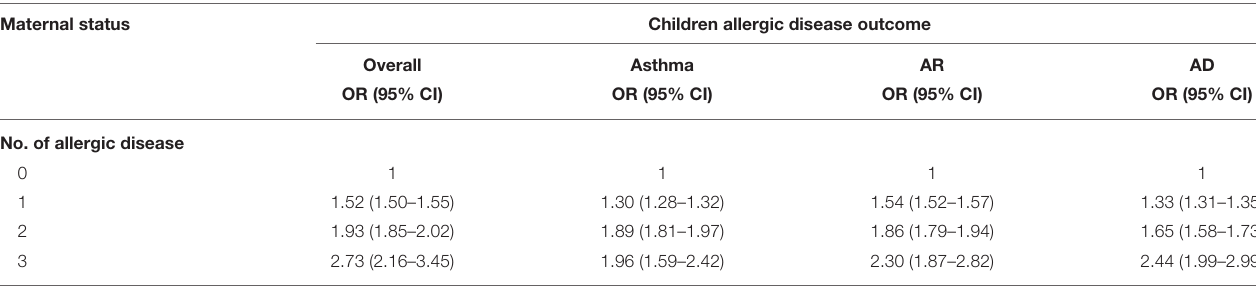
TABLE 4 | Overall risk of childhood allergic diseases in mothers with one, two, or three allergic diseases. Maternal status Children allergic disease